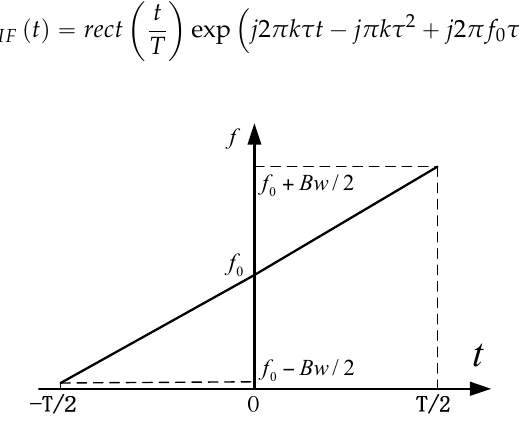
Figure 1. Time frequency plot of a sawtooth sweep chirp.